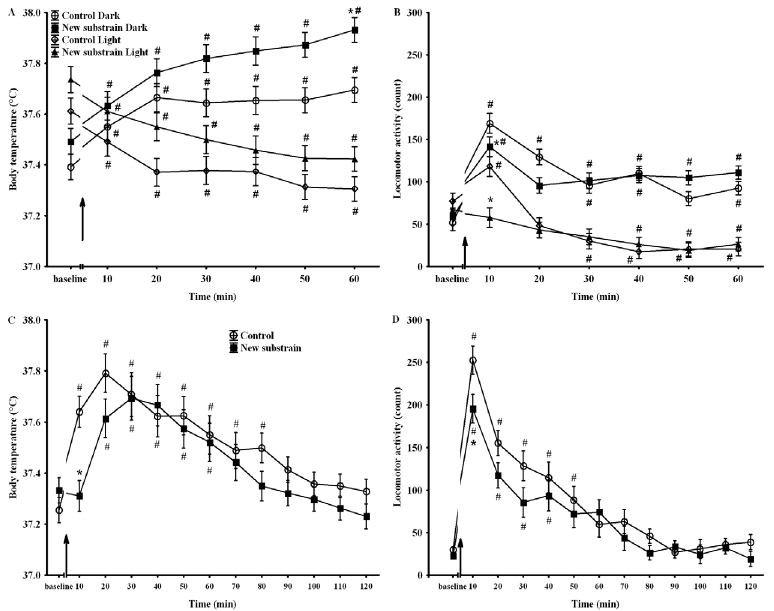
Fig 4. BT (A) and motor activity (B) alterations during the light-phase changes for an hour. BT (C) and motor activity (D) changes after interventions for two hours. " signs the beginning of changes in light condition or the interventions. * p < 0.05 between groups; # p < 0.05 compared to baseline. Data are presented as means ± SEM.